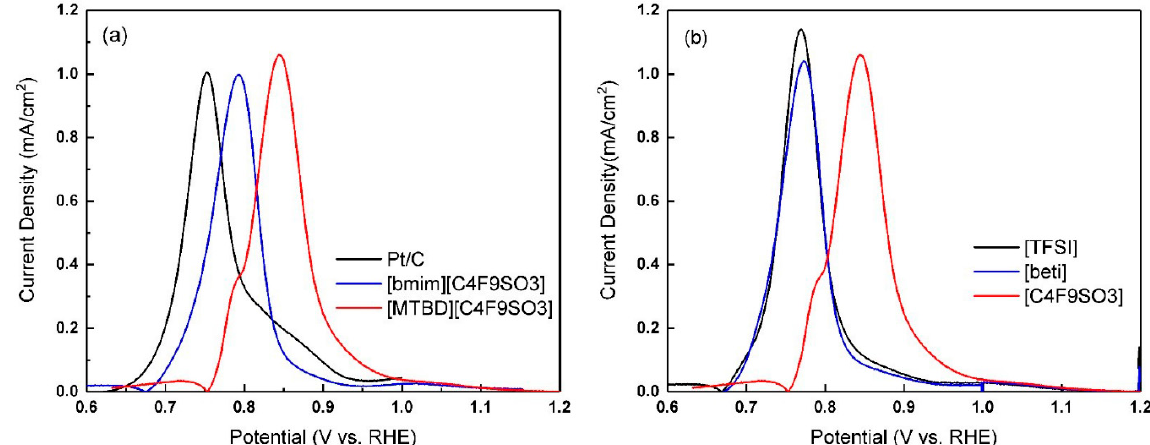
Figure 4. CO stripping measurements. ( a ) Stripping voltammograms of Pt/C, Pt/C-[bmim] [C 4 F 9 SO 3 ], and Pt/C- [MTBD][C 4 F 9 SO 3 ]. ( b ) Stripping voltammograms of Pt/C-[MTBD][TFSI], [MTBD][beti], and [MTBD][C 4 F 9 SO 3 ].